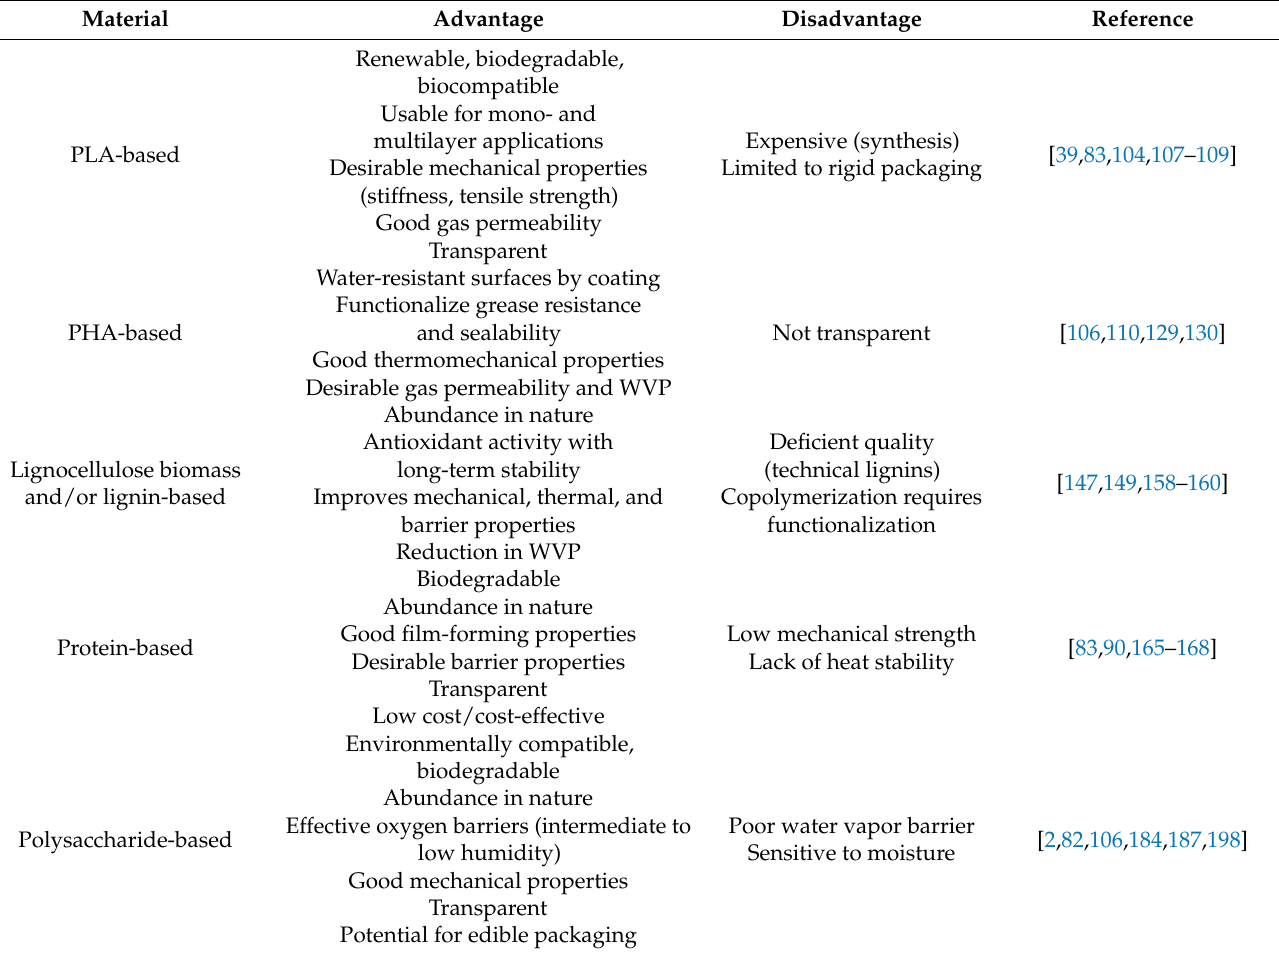
Table 5. Advantages and disadvantages of different bio-based polymers discussed in Section